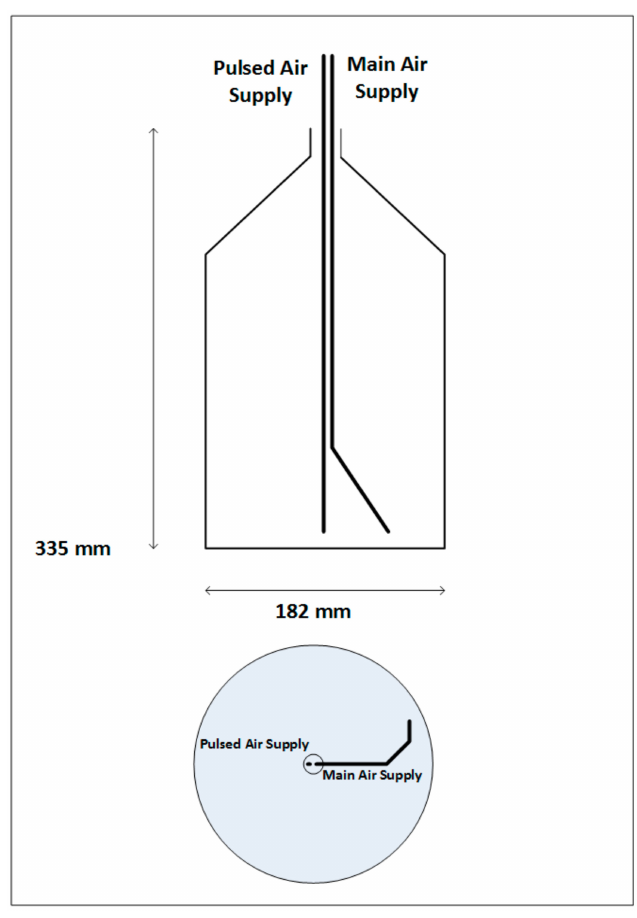
Figure 2. Schematic of aerosol